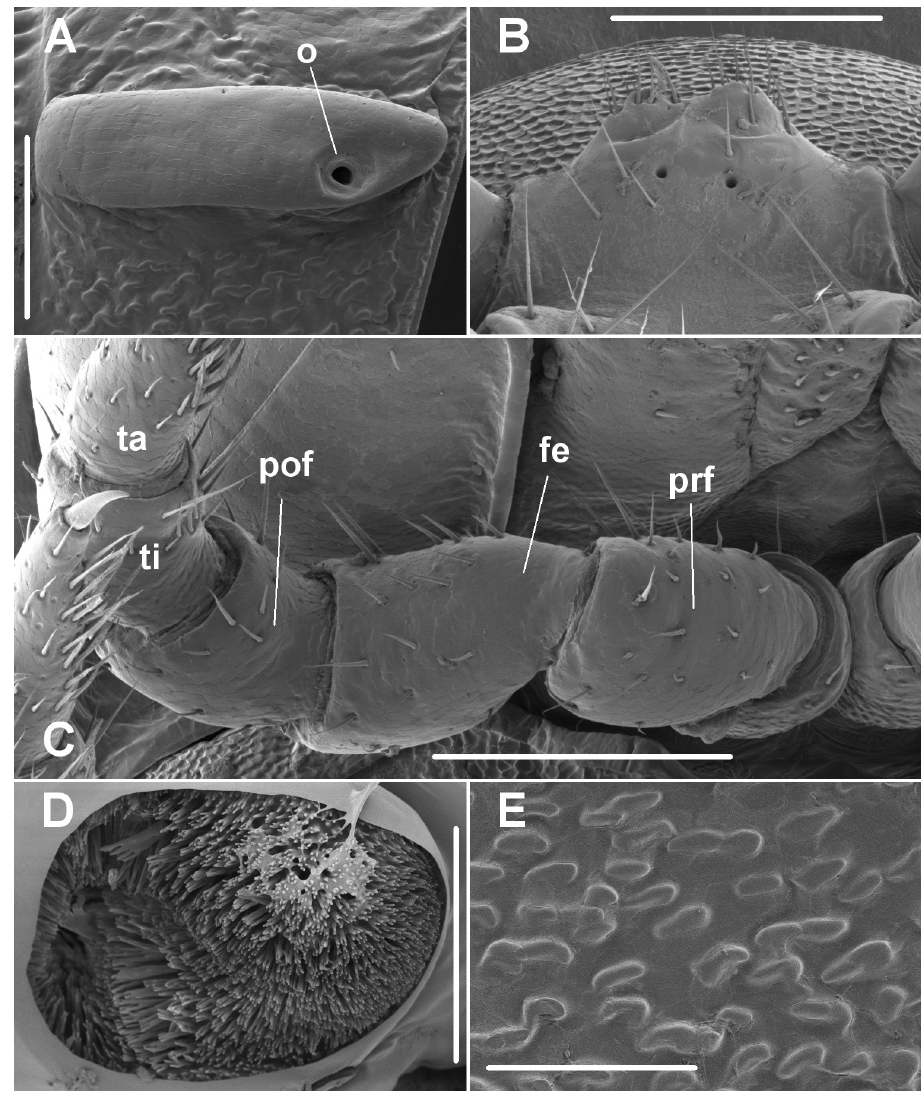
Figure 4. Tridactylogonus warrenbenensis sp. n., male (SAM OM2195). A Left lateral view of midbody paranotum; o = ozopore B Posterior view of sternal lamella between legs 5 C Posteroventral view of right leg 1; fe = femur, pof = postfemur, prf = prefemur, ta = tarsus, ti = tibia D Left lateral view of anterior spiracle on midbody ring E Close-up of microscopic ridges below paranotum in A . Scale bars: 0.2 mm ( A, B, C ); 0.05 mm ( D ), 0.1 mm ( E